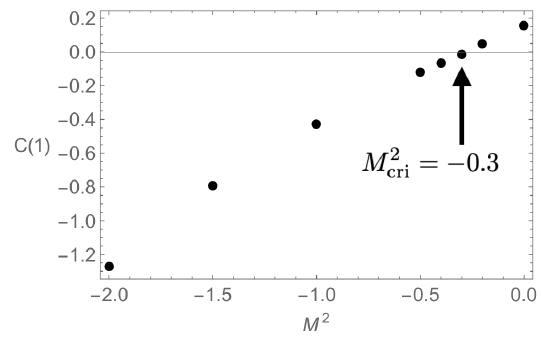
Figure 6 . C (1) vs M 2 at T/T c = 0 . 2